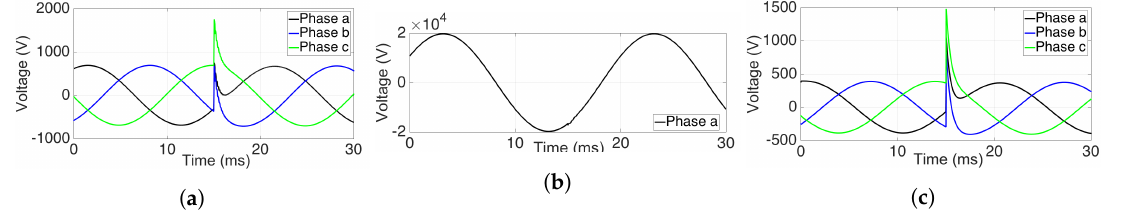
Figure 12. Impact of comprehensive wind turbine model with PMGS on transient overvoltages. ( a ) LV side of the main transformer; ( b ) HV side of the main transformer from node to ground; ( c ) control